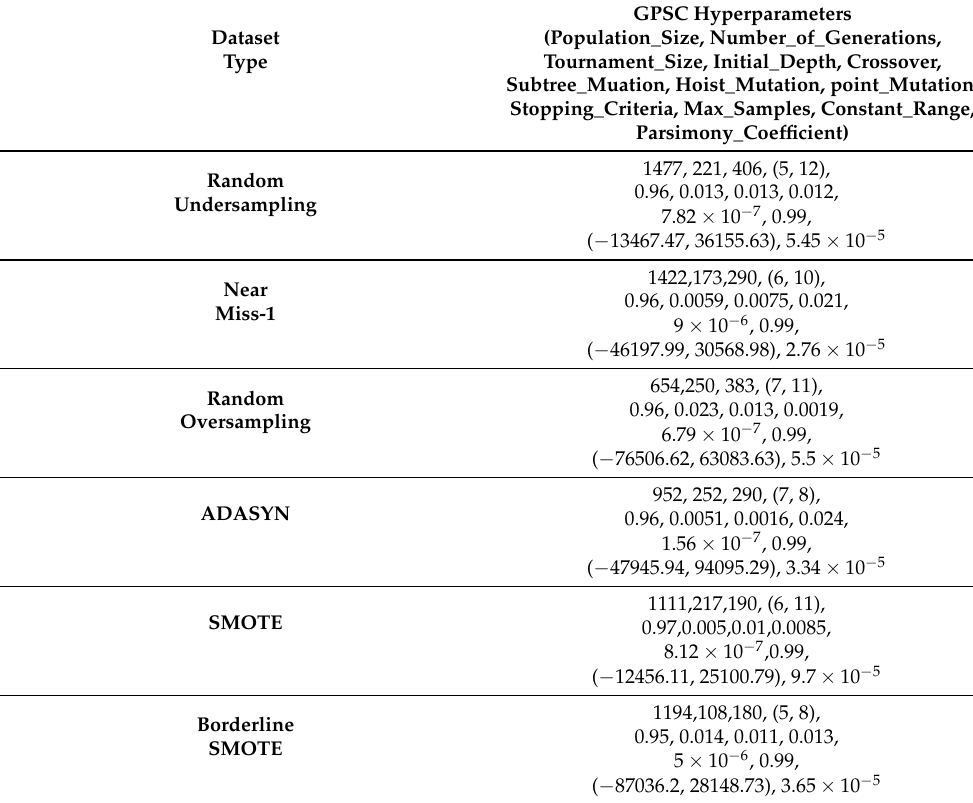
Table 6. The randomly chosen hyperparameters with which the symbolic expressions with the highest classification accuracy were